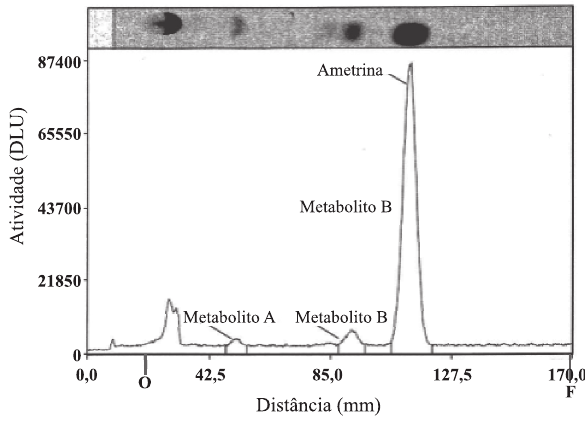
Figura 4. radioimagem da placa de ccd do extrato do solo lvdf após 120 dias de incubação. Quadro 3. distribuição da radioatividade no extrato do solo lvdf